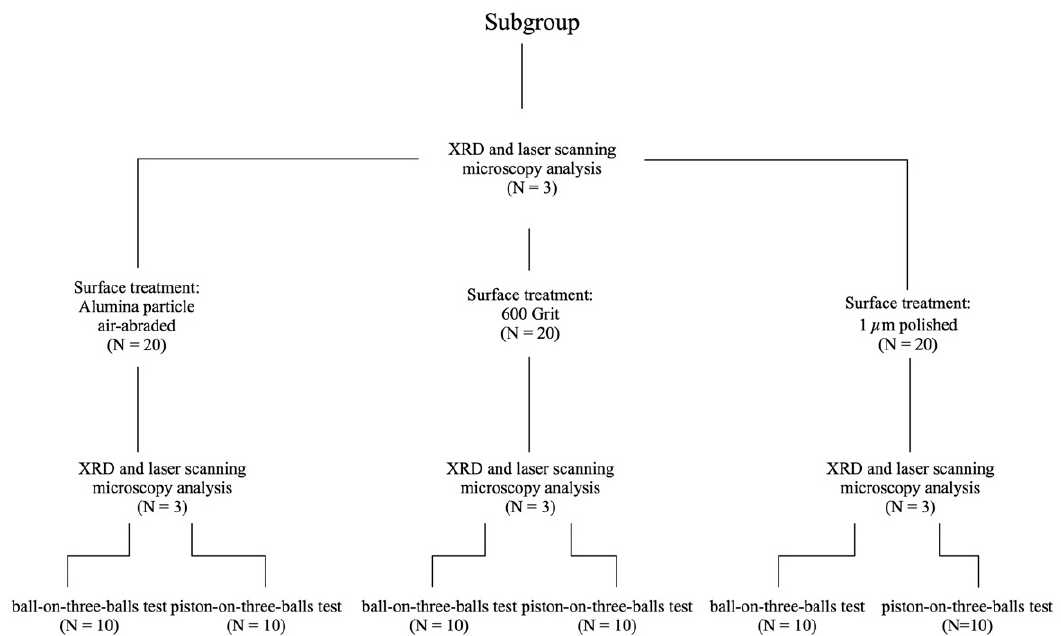
Figure 1. Flowchart of the specimen groups. Subgroups being 3Y-TZP sintered before and after cutting and the different Layers of 5Y-PSZ sintered before and after cutting.